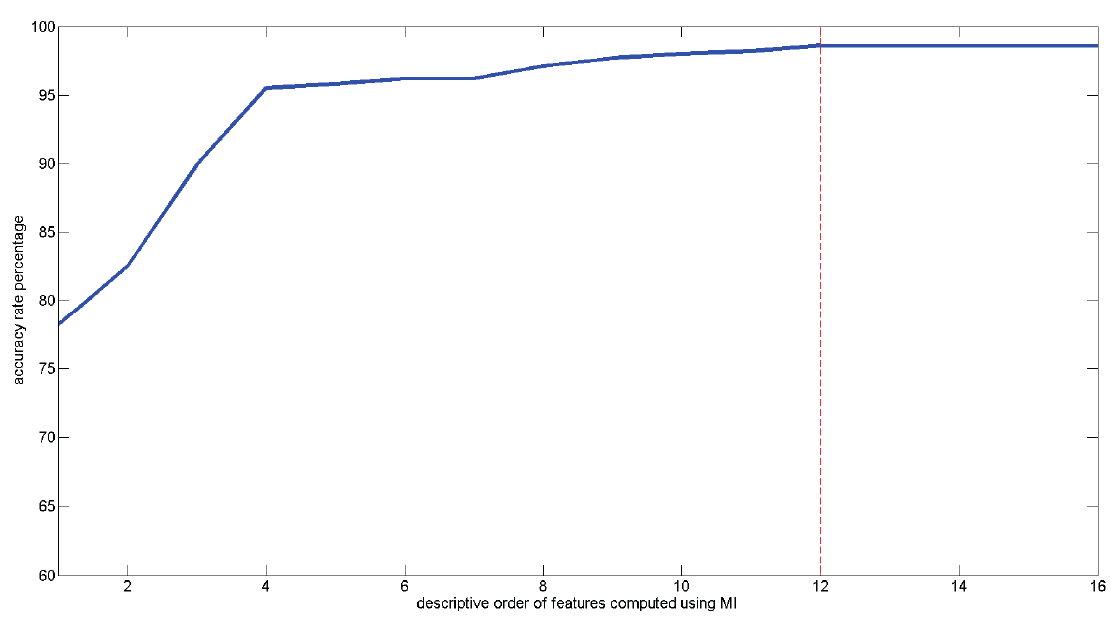
Figure 6. Accuracy rate of the SVM classifier corresponding to the number of features used to predict the driver awareness level. The choice and number of features adopted are based on the rank of the most descriptive features in Table 4 in descending order.